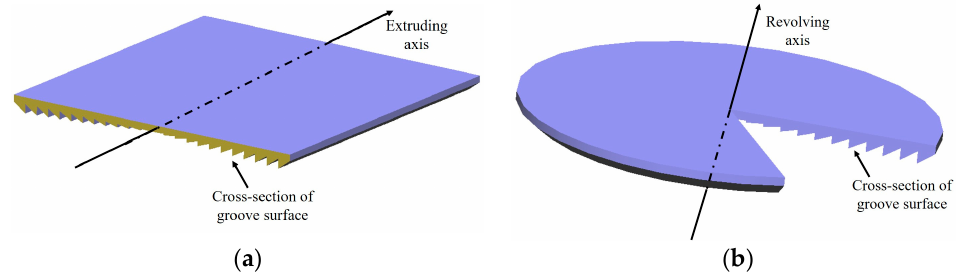
Figure 1. Two types of Fresnel lenses constructed from a cross-section of the grooves with ( a ) extruding axis and ( b ) revolving axis.